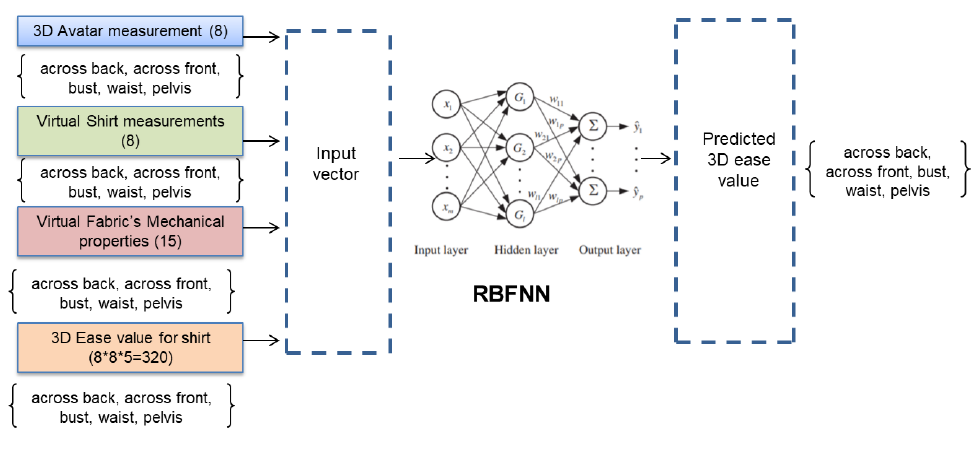
Figure 6. Architecture of ease prediction model.